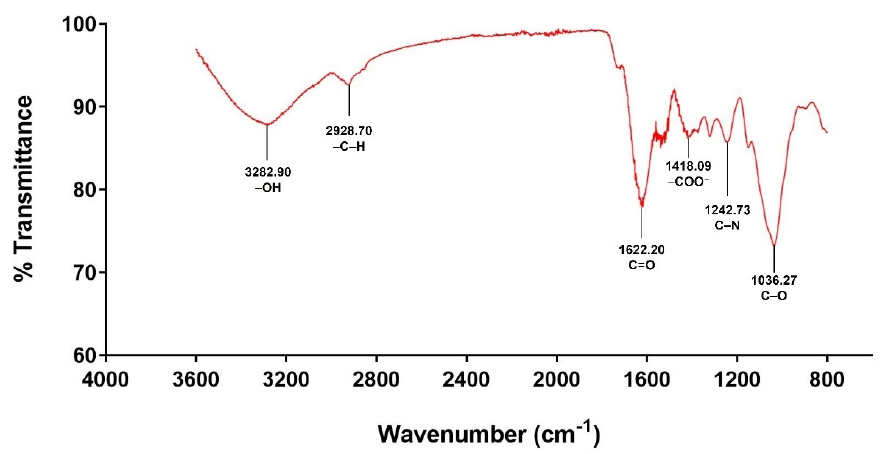
Figure 2. FT-IR spectrum of mucilage extracted from Corchorus olitorius L.